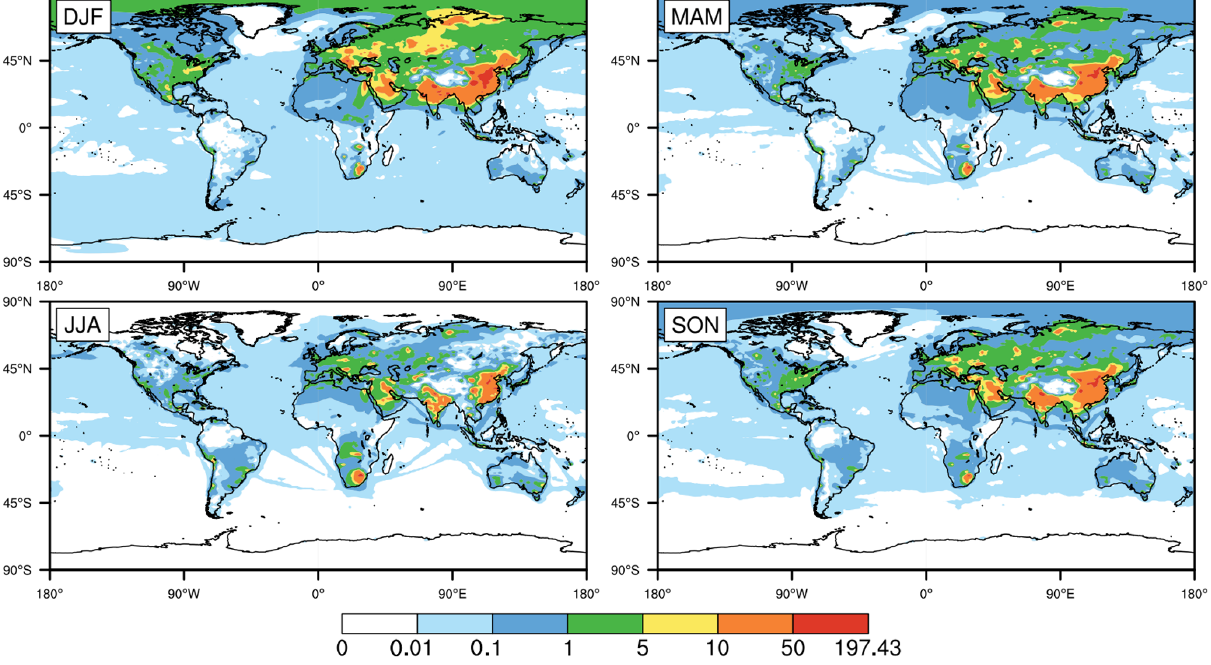
Figure 2. Global distribution of seasonally averaged surface mixing ratios of SO 2 (in parts per billion by volume; hereafter ppbv) in 2015, simulated by CESM2 with standard configuration (i.e., the original case). DJF, MAM, JJA, and SON represent